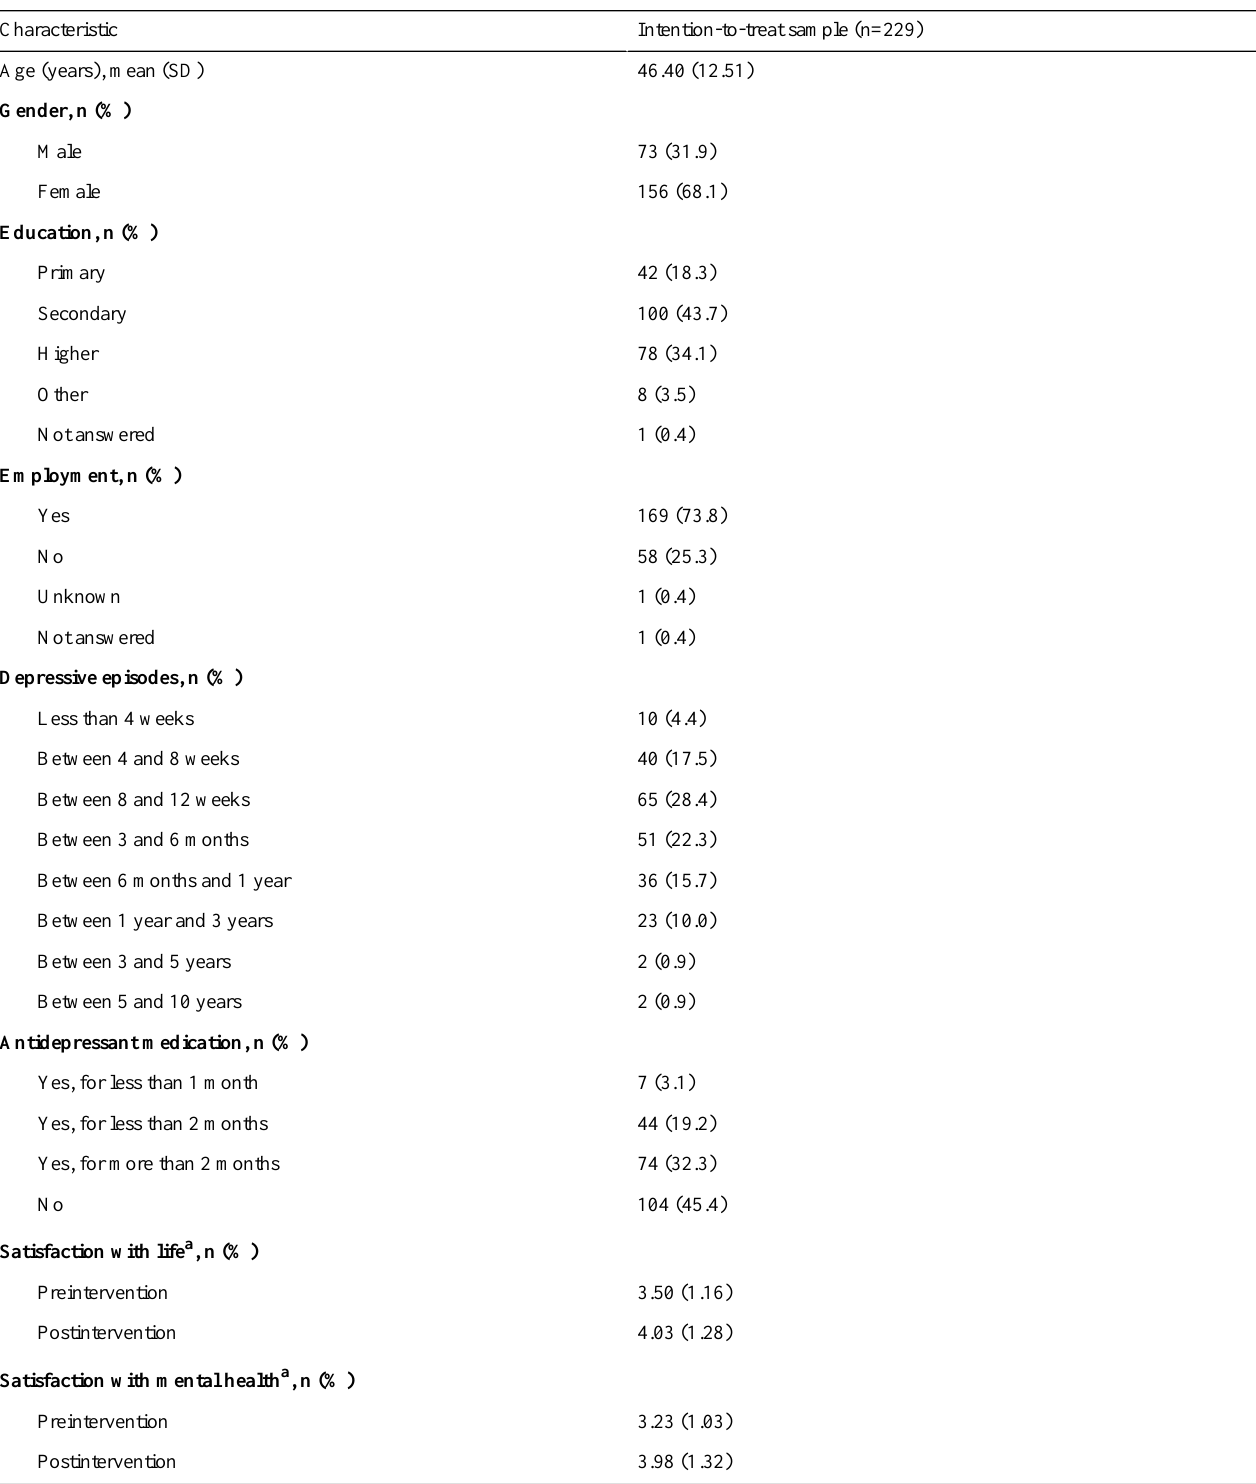
Table 1. Clinical and demographic baseline characteristics of the participants who started the treatment.